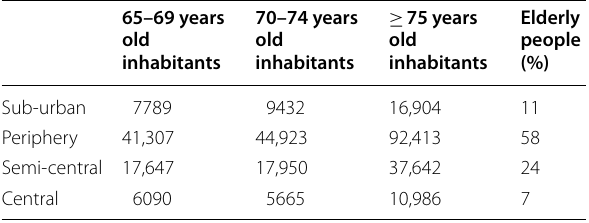
Table 2 Elderly people distribution per age group in the urban zones (ISTAT, 2011)